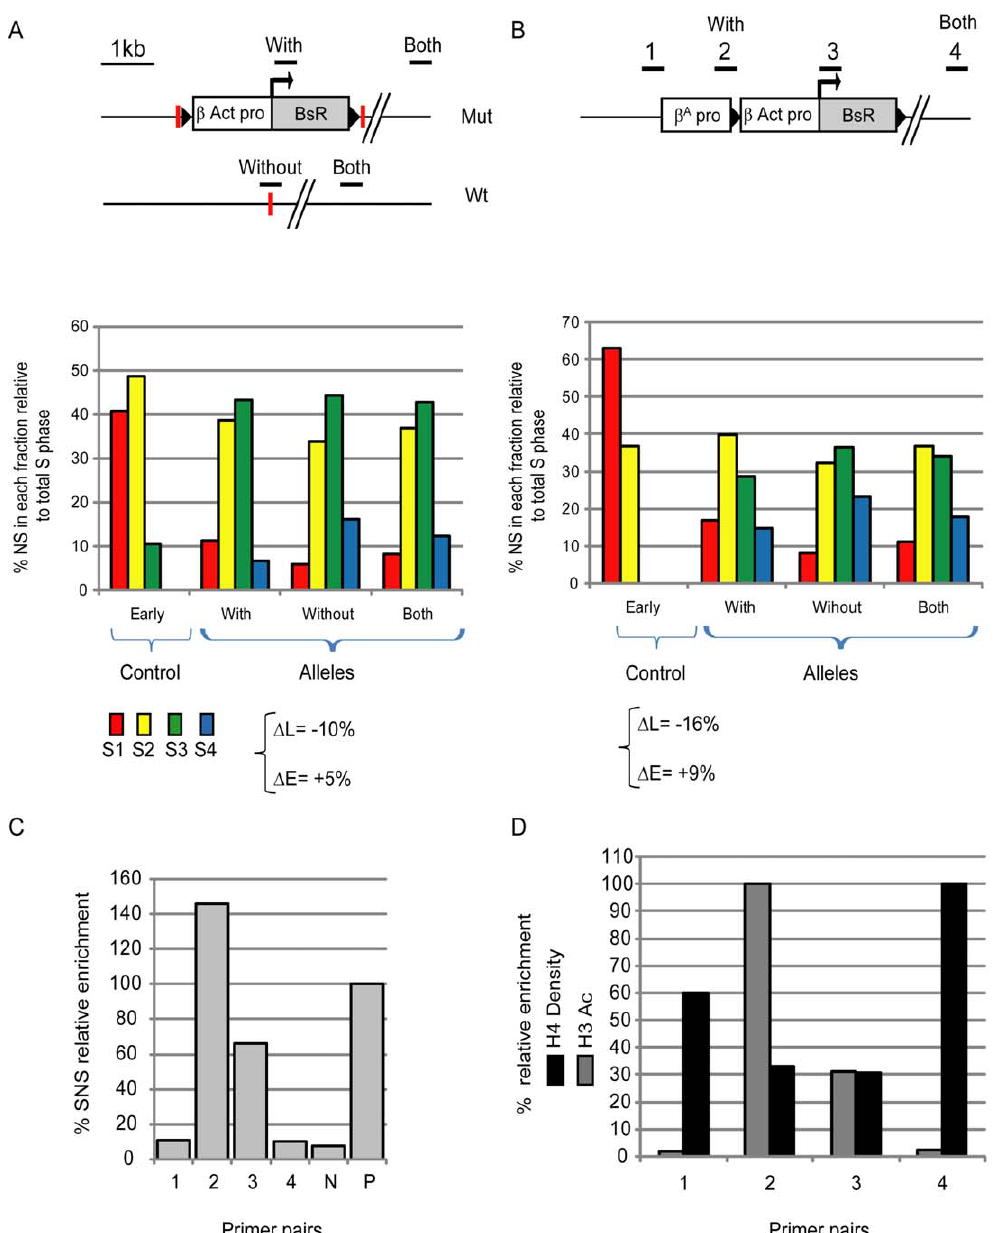
Figure 4. A strong origin linked to a transcriptionally active transgene has a minimal effect on replication timing. (A and B) Replication timing profiles of chromosomal alleles following targeted integration of transgenes into a late replicating locus of DT40 cells described in Figure 2. (A) Analysis of a transgenic line containing a blasticidin resistance gene (grey rectangle) under the control of the b -actin promoter (white rectangle) targeted into the site of integration (red vertical bar). The modified (Mut) and wild type (Wt) alleles are represented together with the location of amplicons used for timing analysis. (B) Analysis of a transgenic line containing the same transgene linked to the b A -globin promoter/replicator. Only the modified allele is shown with the position of amplicons used in QPCR analyses. (A and B) Cells were BrdU pulse labeled, sorted into four S-phase fractions and nascent strands quantified by real-time PCR (S1 in red, S2 in yellow, S3 in green, and S4 in blue). Three different PCR primer sets were used to measure the replication timing at the site of integration on either the transgenic allele (With), the endogenous allele that lacks transgene integration (Without), or both alleles (Both). The endogenous b -globin locus was analyzed as an early replicated control. The differences in late or early replication ( D L and D E) at the target site following transgene integration are shown. (C) Quantification of SNS enrichment over the b A -globin / b - actin transgene. Three transgene-specific primer sets were used (1–3, indicated in B); primer set 4 is located 5 kb from the integration site. SNS enrichments are relative to those of the endogenous r -globin positive control origin (P). A region located 21 kb upstream of the endogenous HS4 insulator that is devoid of origin activity was analyzed as a negative control (N). (D) ChIP analysis of H3K9acK14ac and H4 density along the b A -globin/ b -actin transgene. Histone H3 acetylation levels are relative the b -actin promoter (region 2) and H4 density is relative to distal region 4.